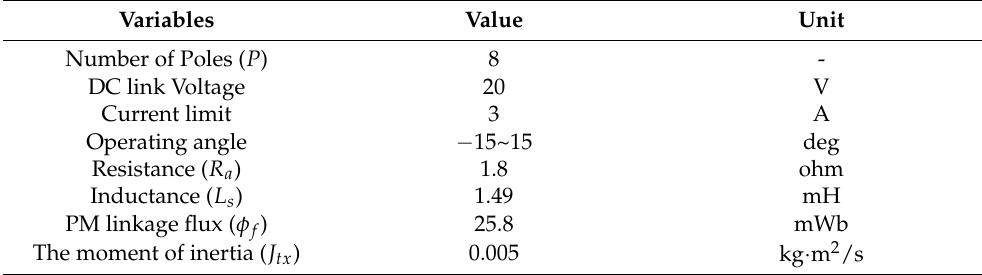
Table 3. Specifications for tilting